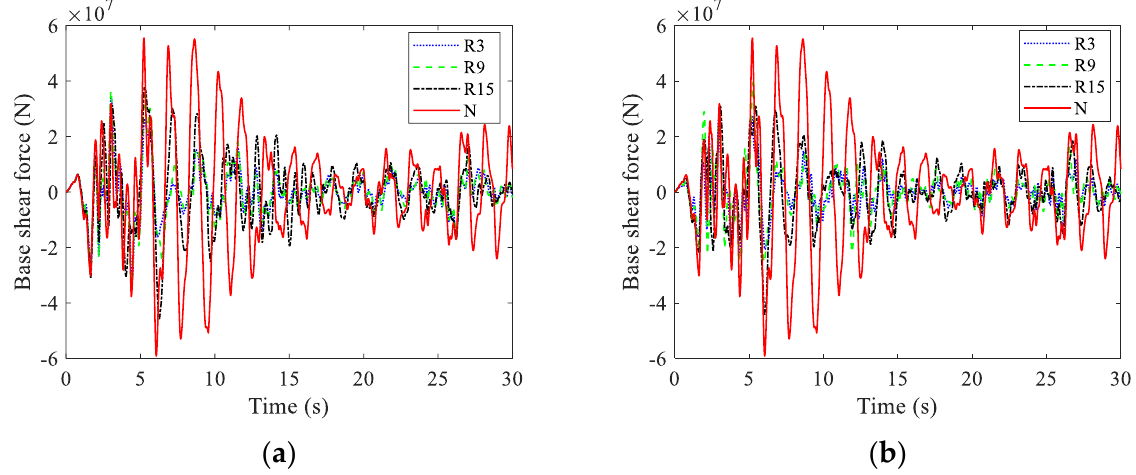
Figure 17. Base shear response of model 1 (El Centro): ( a ) base shear of the left building; ( b ) base shear of the right building. Table 2. Damping effects for the top floor response (El Centro).